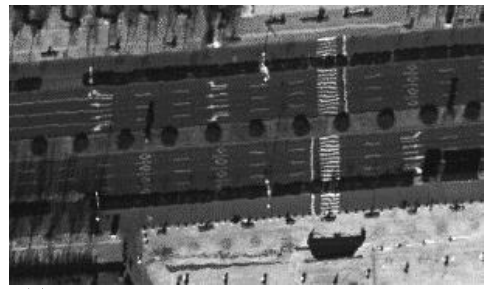
Figure 5. Geometric rectification result based on unequal segmentation